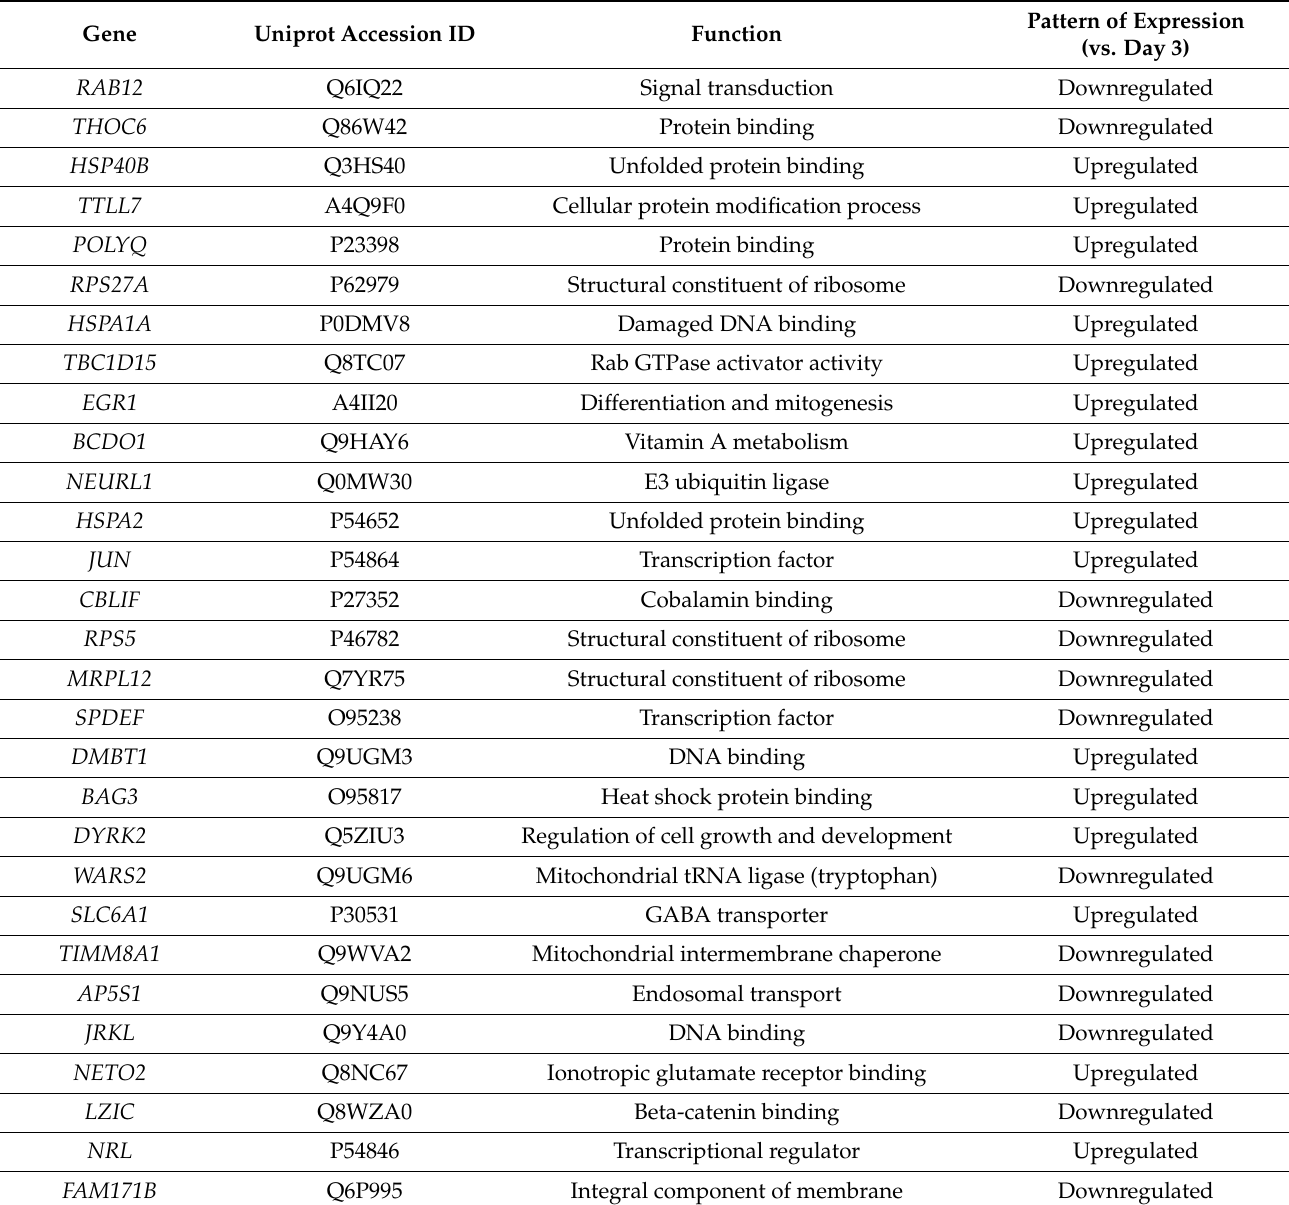
Table 1. Genes with most significant differential